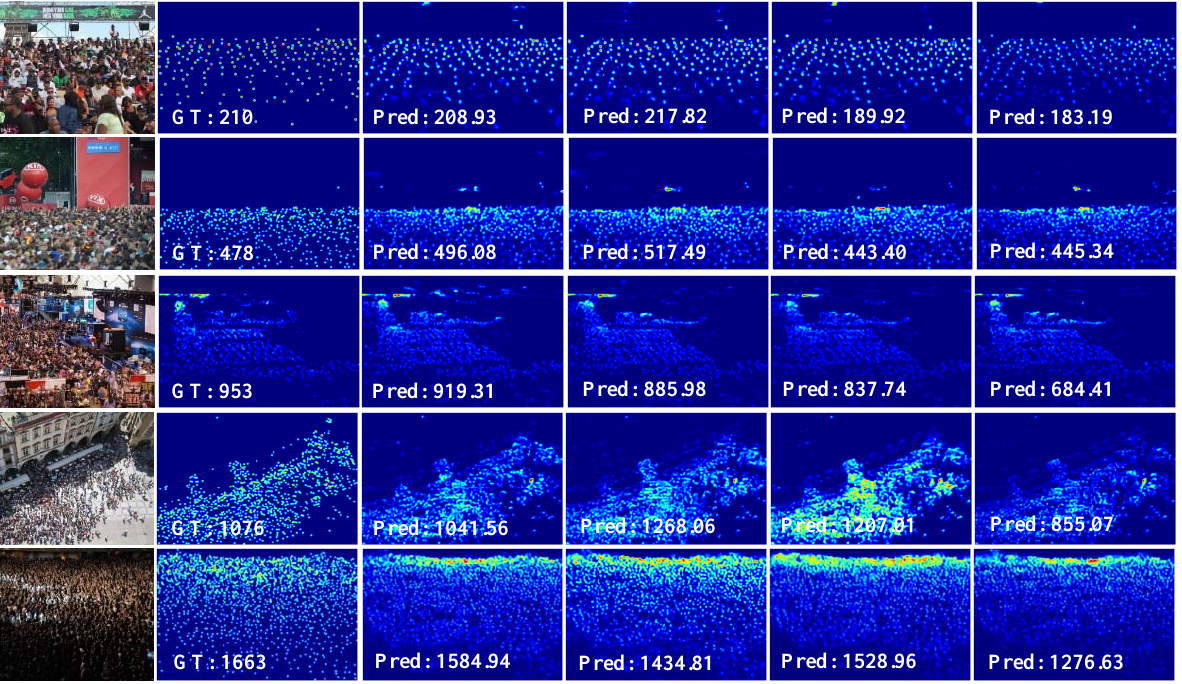
Figure 8. Visual comparision of different multi-scale context modules on UCF-QNRF. From left to right: input images, ground-truth, results of our method, results of CCPM, results of SPM, and results of